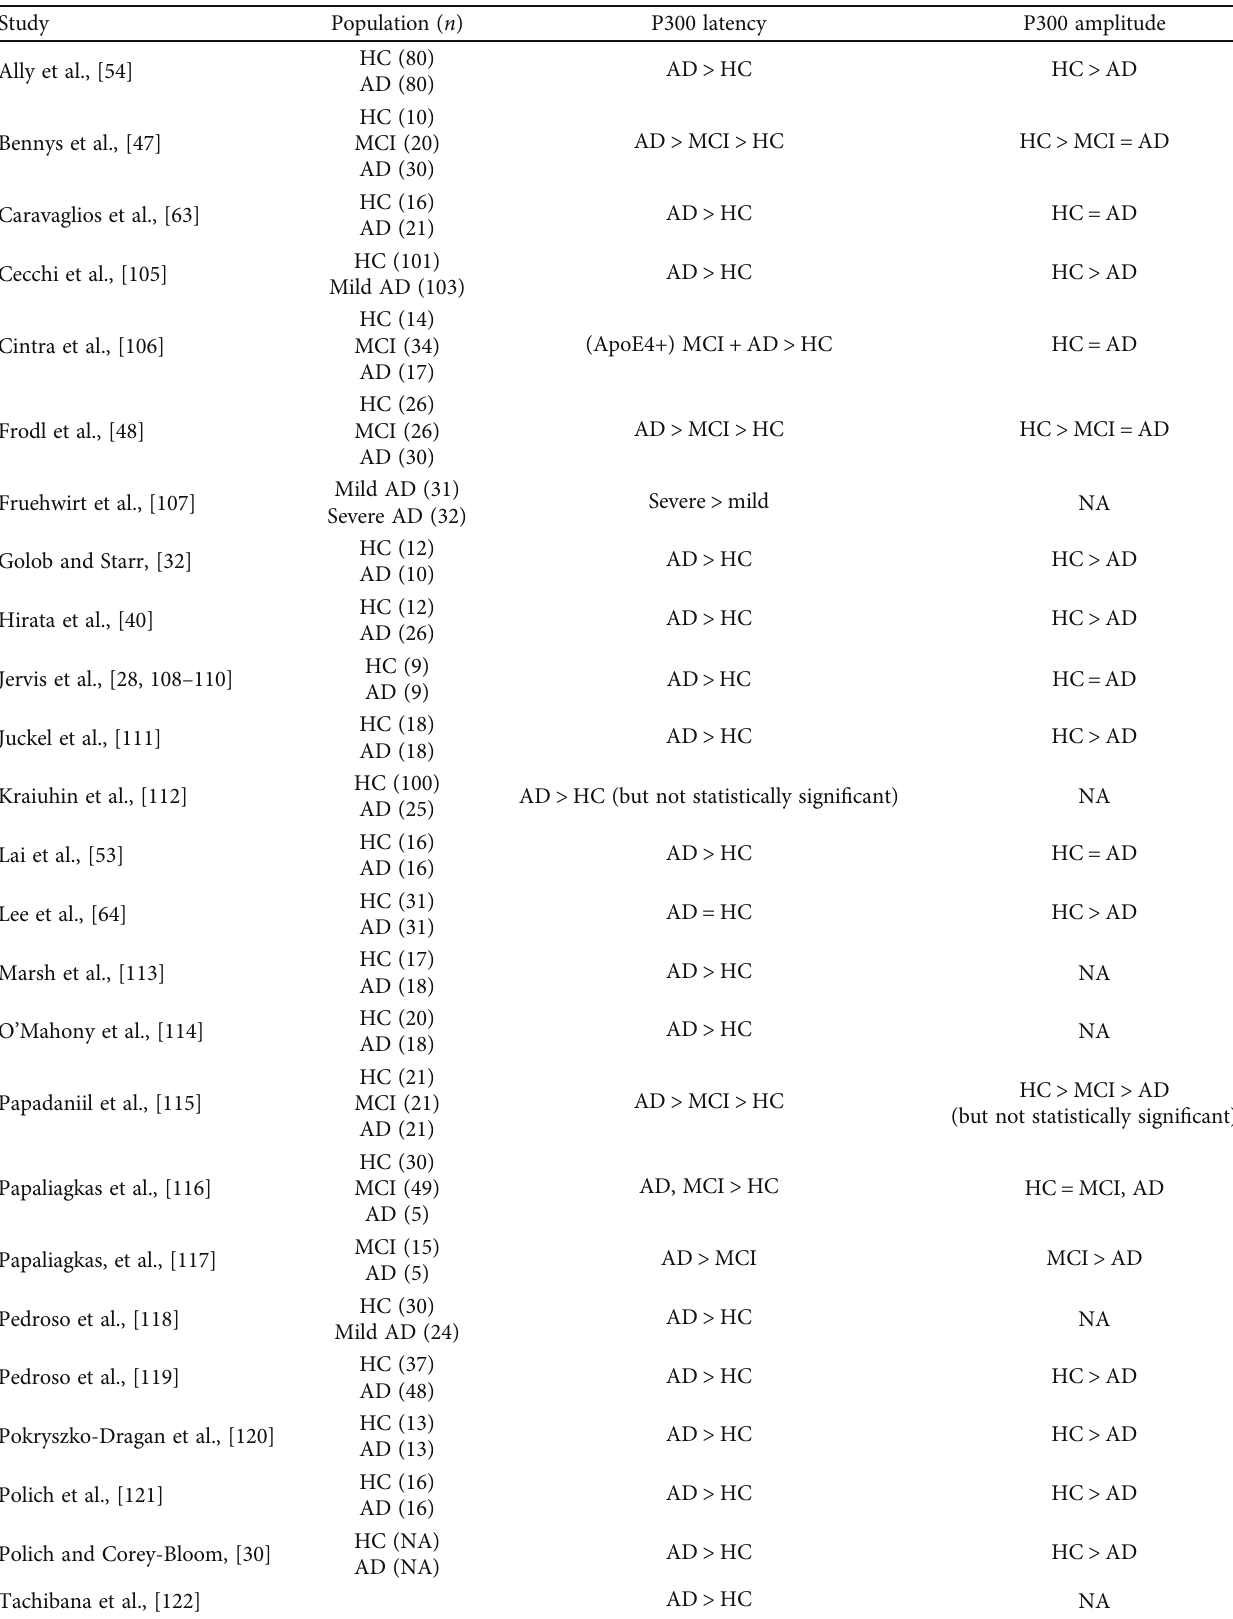
Table 1: ERP P300 studies in patients with